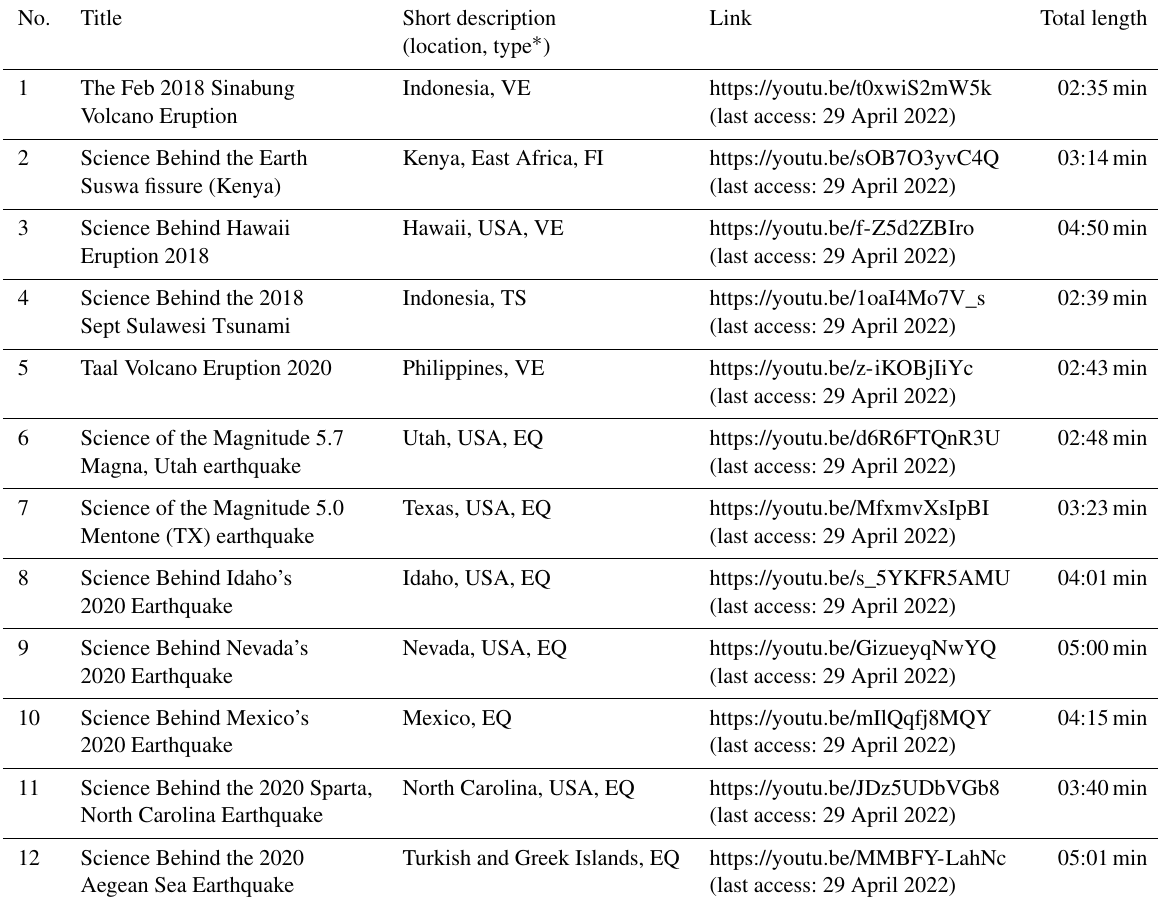
Table 1. List of 12 Geonews videos